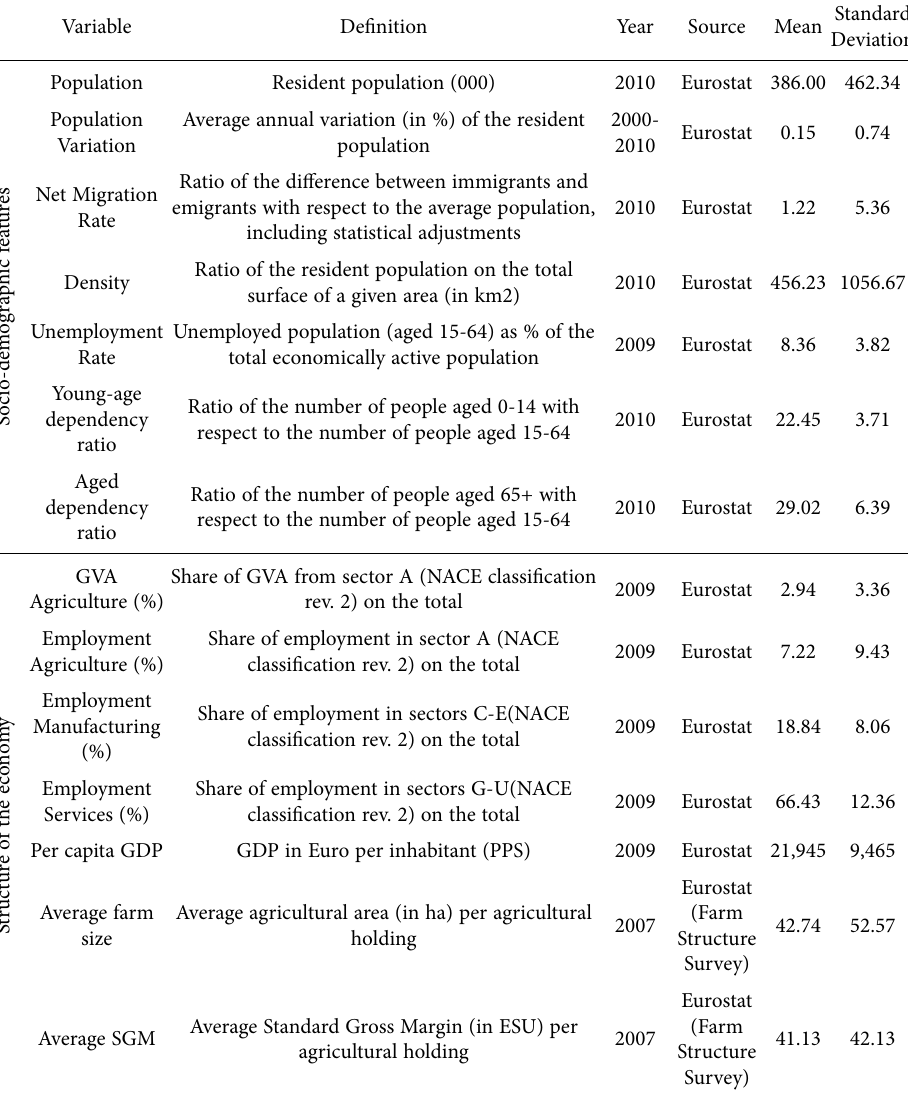
Table 1. Variables adopted in the analysis grouped in 4 thematic